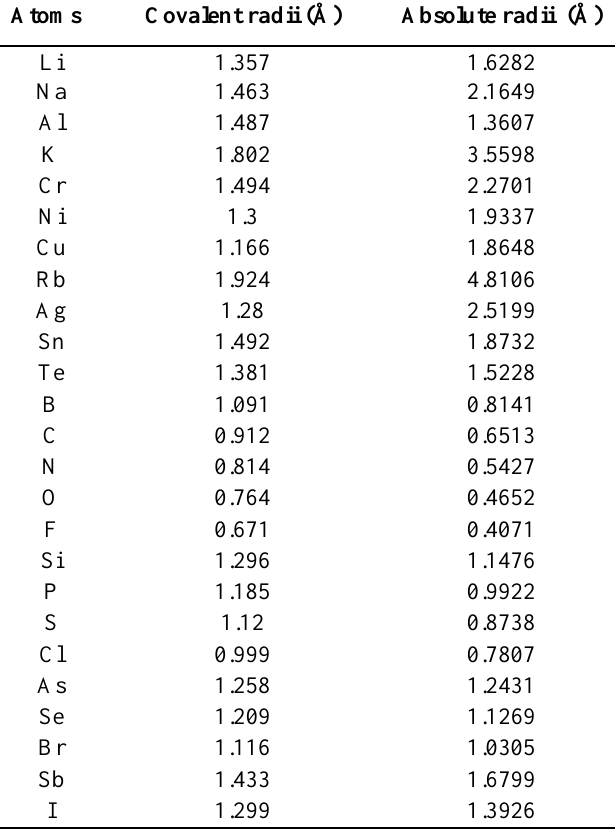
Table 6. Comparative study of absolute radii and covalent radii of Politzer-Parr-Murphy. Atoms Covalent radii (Å) Absolute radii